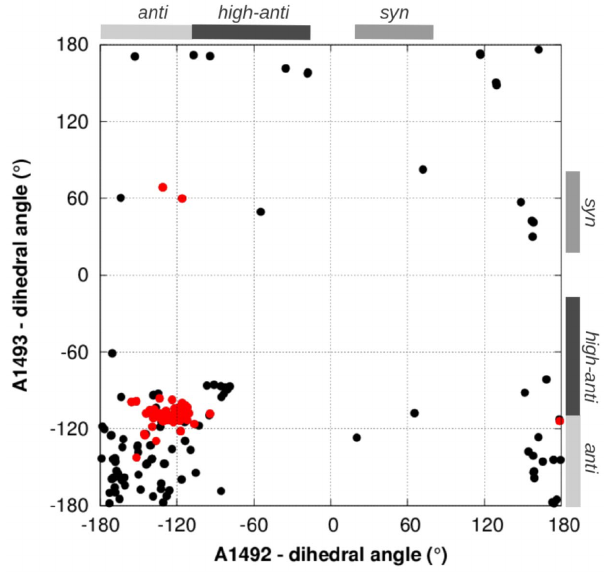
Figure 5. Glycosidic angles of A1492 versus A1493, derived from crystal structures of bacterial ribosomes, with and without A-site tRNA (49 and 126 structures, respectively). Data points for structures with bound A-site tRNA are colored red. The high- anti , anti and syn ranges are indicated.